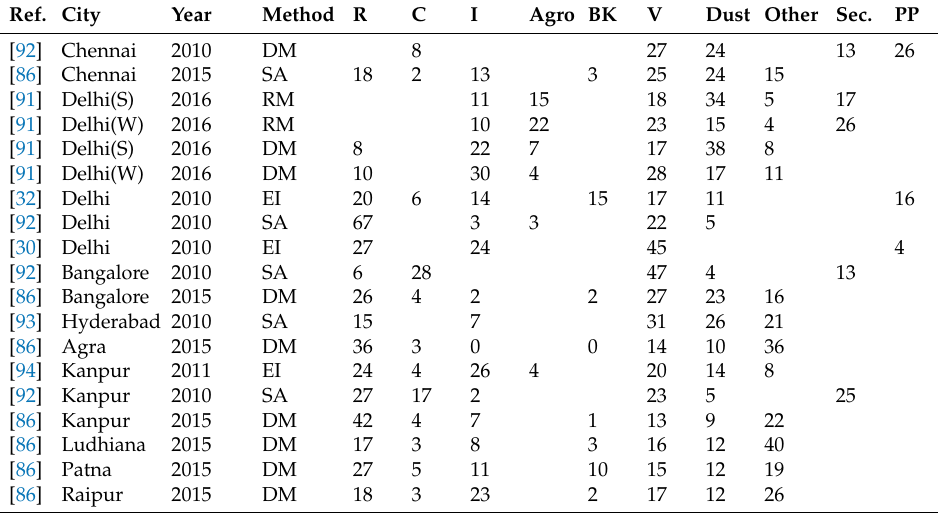
Table 6. Summary of recent source contribution studies (in percentage) by emission mass contribution or concentration contribution using dispersion modeling (DM), source apportionment (SA), bottom-up emission inventory (EI), receptor modeling (RM) methods are shown here. The sectors residential (R), commercial (C), industrial (I), biomass burning (agro), brick kiln (BK), vehicles (V), construction dust (dust), other non-accounted sources (other), secondary particles (Sec.) and power plants (PP). Summer and winter time contribution are denoted by S and